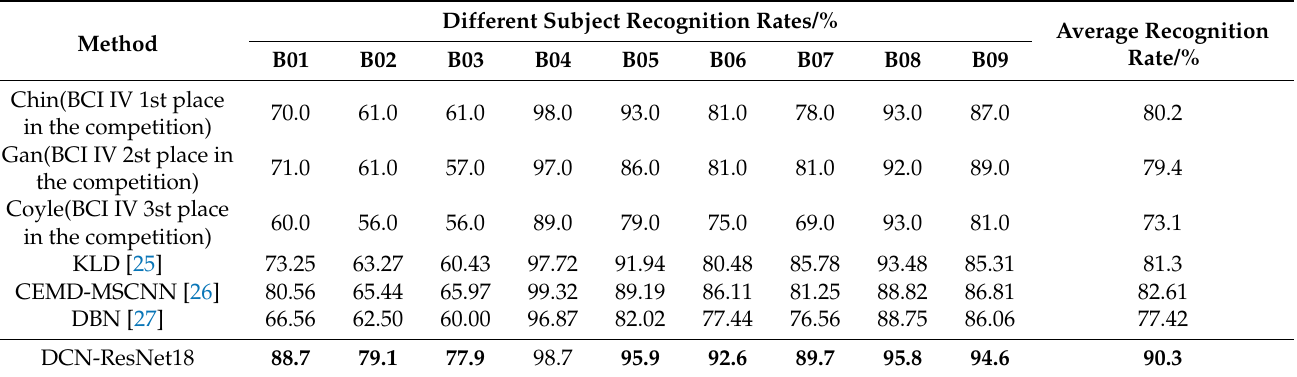
Table 6. Comparison of the recognition accuracy of different methods on BCIC IV dataset 2b